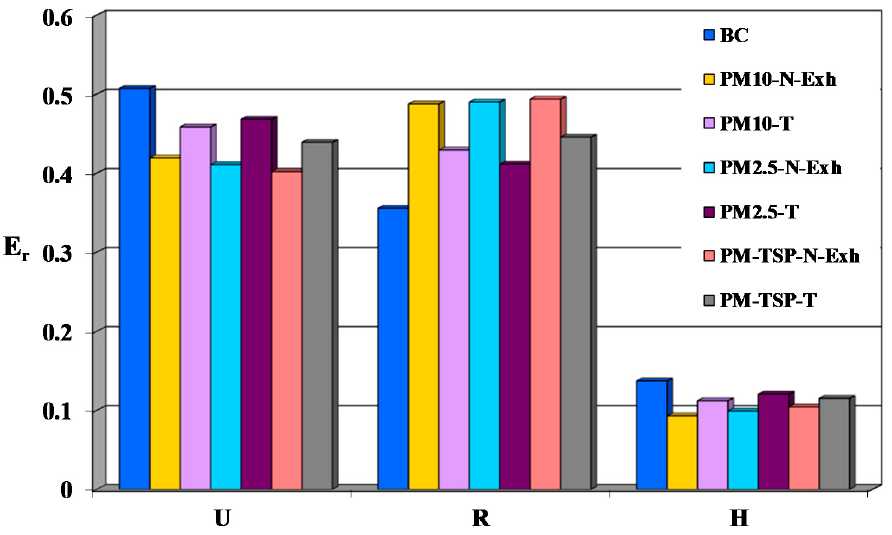
Figure 15. Relative national annual emissions (Er) of particulate matter from road transport under different traffic conditions: urban (U), rural (R), highway (H) and total (T).